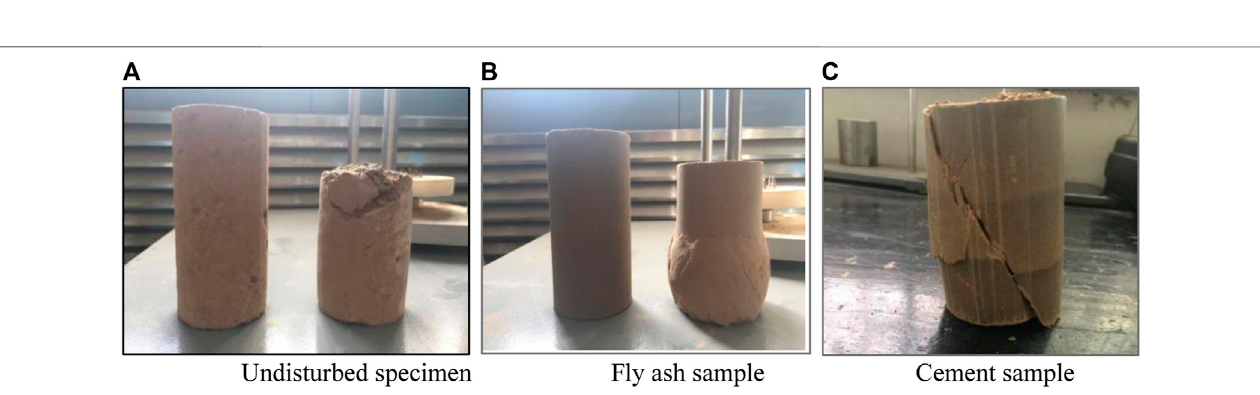
FIGURE 9 | Macroscopic failure of the original, fl y ash, and cement samples after the test. (A) Undisturbed specimen, (B) fl y ash sample, and (C) cement sample.